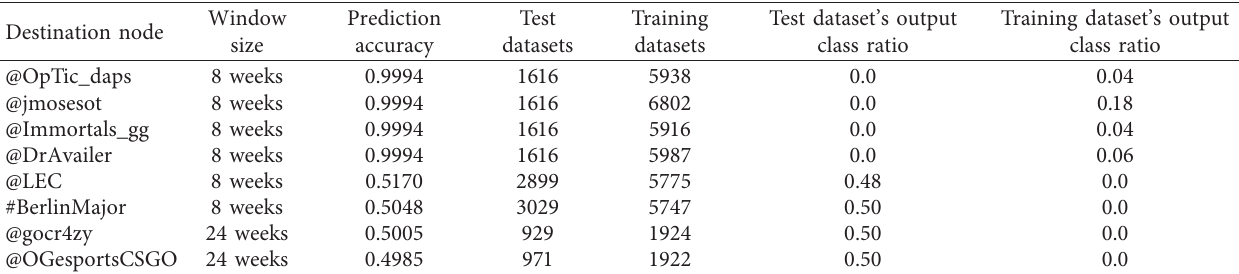
Table 2: A selection of iterations with outstanding accuracy of predictions. Source: own elaboration.